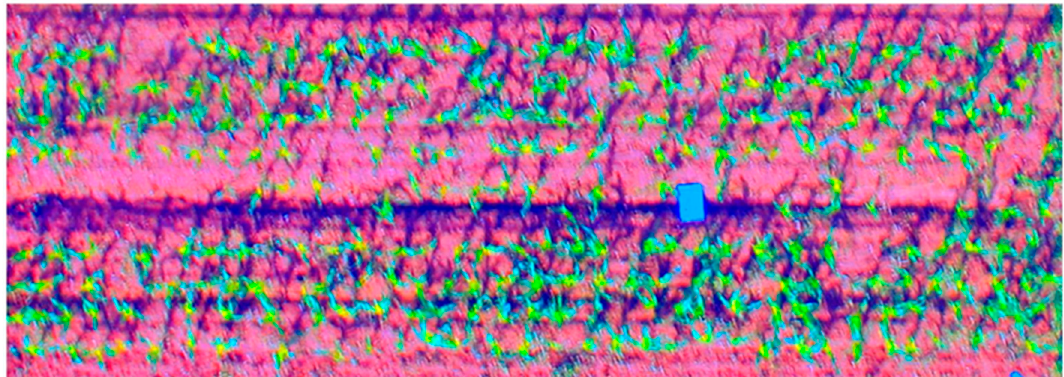
Figure 7. Image after adapting the contrast with a decorrelation of MATLAB. The function highlights elements by enhancing the color differences indicated for plot number 12. Moreover, MATLAB offers various parameters to be set for the decorrelation stretch. We used the following command: P_Contrast = decorrstretch(P, ‘Tol’, 0.01); where “P” is the image, “Tol” is the linear contrast stretch, which further expands the color range and additionally finds limits to contrast the stretch because pixel values must be located in the range [0, 255] and “0.01” (which defines the level of the contrast stretch).